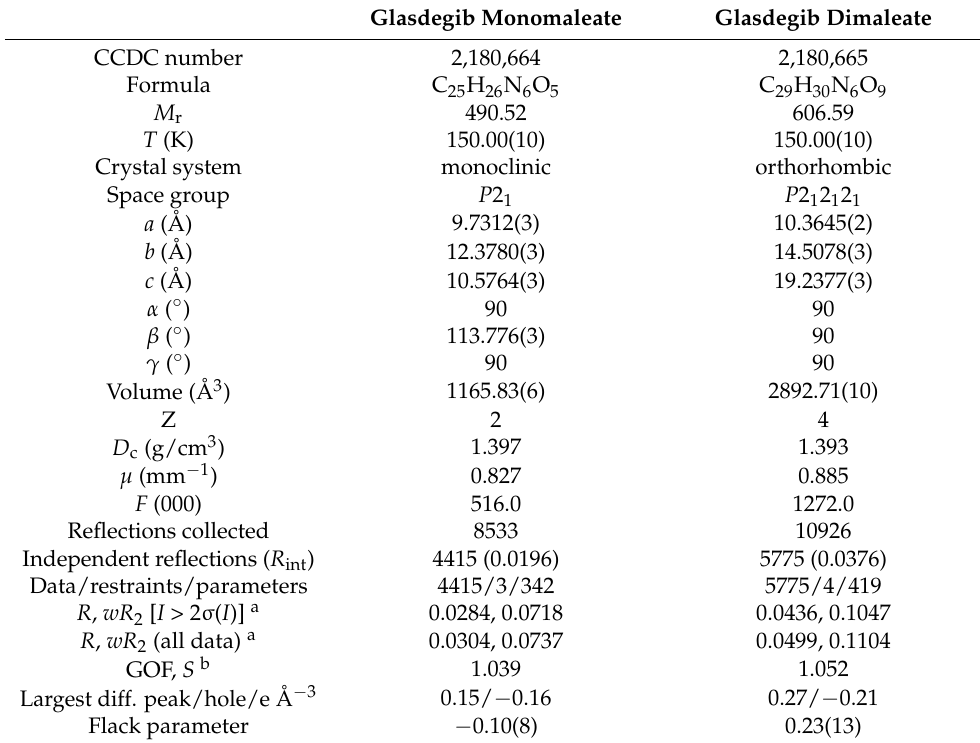
Table 1. Crystallographic data for glasdegib monomaleate and glasdegib dimaleate. Glasdegib Monomaleate Glasdegib Dimaleate CCDC